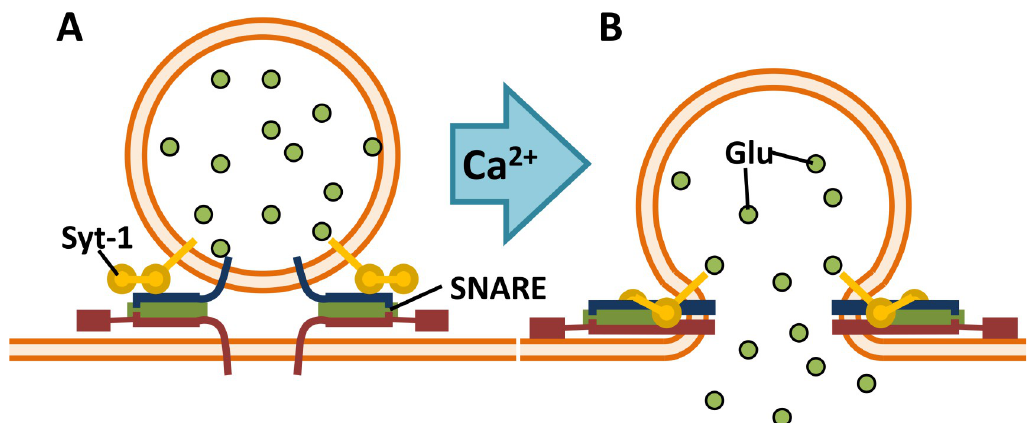
Fig 1. SNARE Complex Structure and Dynamics. (A) SNAREpins prior to vesicle fusion. (B) Binding of Ca 2+ to synaptotagmin (Syt-1 here, Syt-7 attaches to target membrane [6,7]) triggers full zippering of SNARE complex and, in turn, vesicle fusion